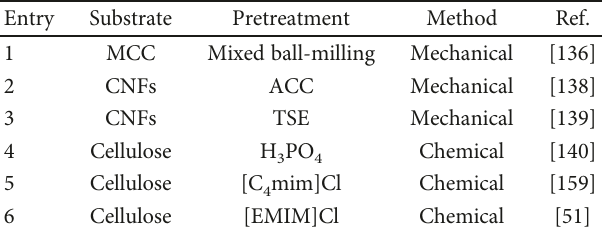
Table 1: Pretreatment technologies for the cellulose species. Entry